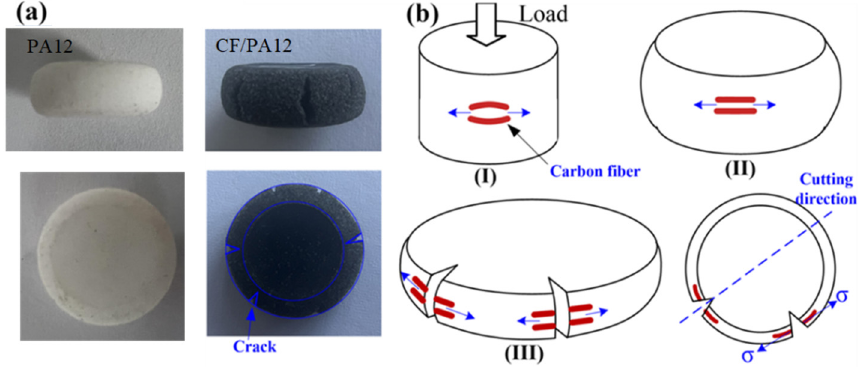
Figure 11. Schematic diagram for the cracking process of CF/PA12 and PA12 Sample: ( a ) PA12 and CF/PA12; ( b ) CF/PA12.